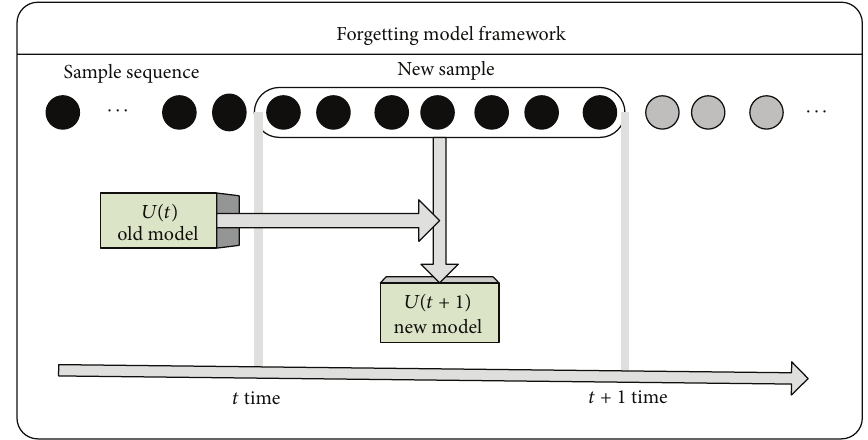
Figure 5: The framework of forgotten model.